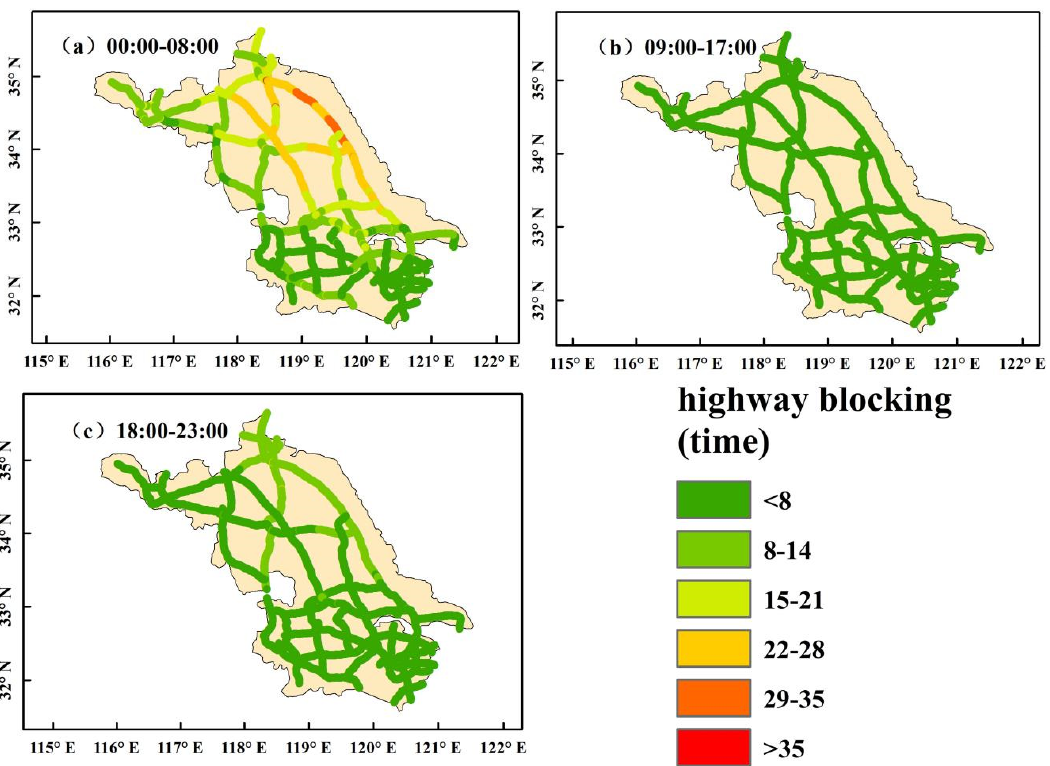
Figure 7. Spatial distributions of highway-blocking events during different time periods in Jiangsu Province, 2020.